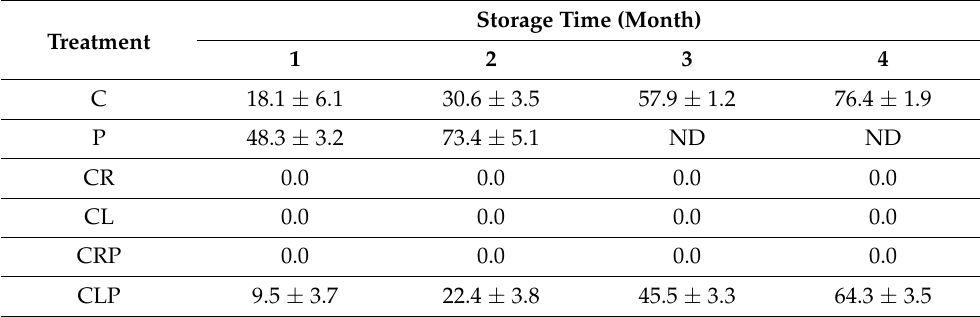
Table 3. Four months evaluation of decay severity (%) of JA tubers stored at 25 ± 2 ◦ C and treated with essential oils under infection by P. polonicum (mean ± SD).